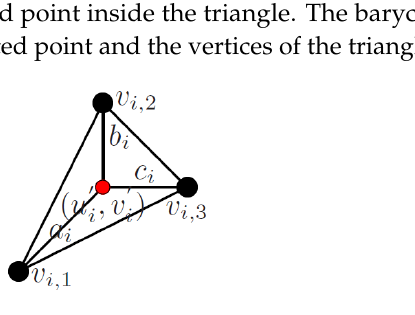
Figure 2. Data association from detected points (red) with model points in mesh